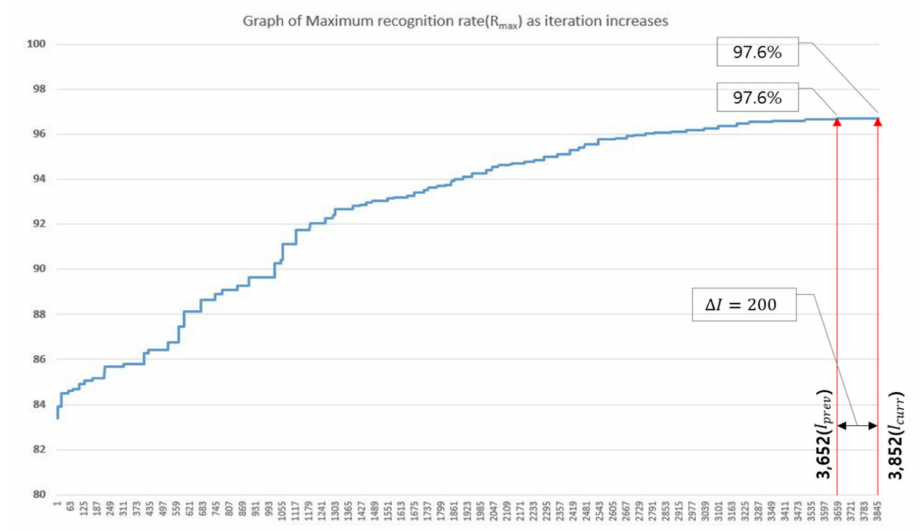
Figure 7. Trend of recognition rate in 1D CNN hyperparameter optimization process using proposed